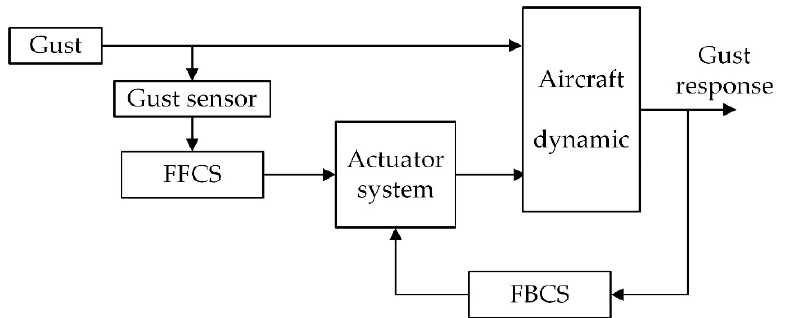
Figure 5. Structure of combined control system.